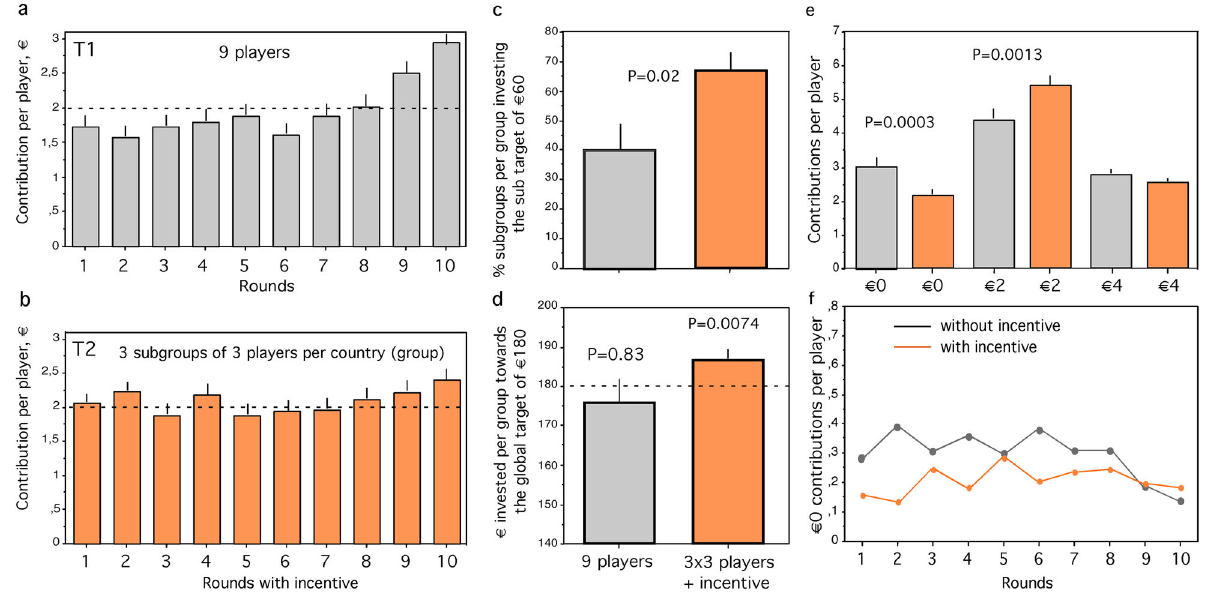
Fig. 2 Investment into climate change mitigation. a Contribution per player of 9 players per group investing individually during each of 10 rounds (T1). Stippled line shows fair share of € 2. b Contribution per player of 9 players per group subdivided into 3 fi xed subgroups of 3 players investing individually in mitigation during each of 10 rounds with an incentive to save energy, bene fi ting own subgroup (T2). c Percentage of subgroups per group investing the sub-target of € 60, for randomly simulated subgroups of 3 players in T1 (grey) and in T2 (orange). d Euros invested per group towards the global collective target of € 180 (stippled line), for T1 (grey) and T2 (orange). e Sel fi sh ( € 0), fair ( € 2) and generous ( € 4) contributions per player per round for randomly simulated subgroups investing without incentive (grey), and for fi xed subgroups with incentive (orange). f Sel fi sh (0 € ) contributions per player in each round for randomly simulated subgroups in T1 (grey) and for the fi xed subgroups in T2 (orange). See text for statistics, bars indicate standard